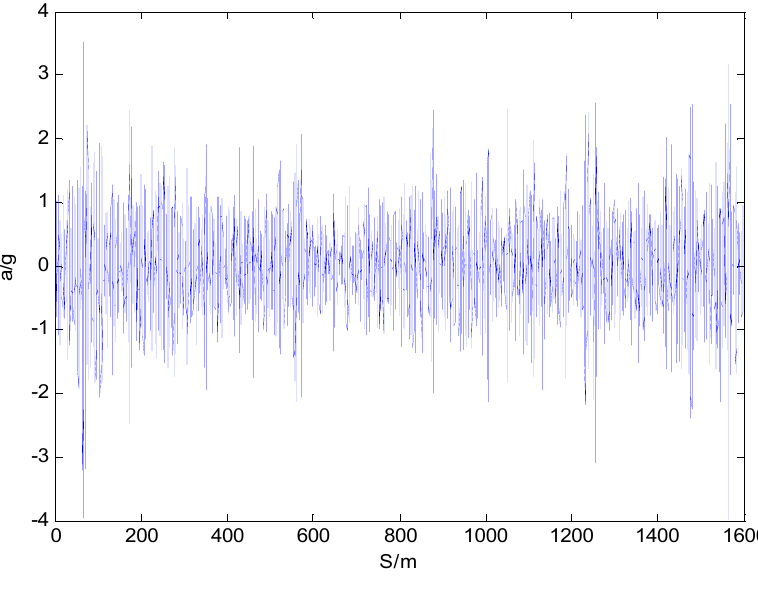
Figure 12. Space PSD of acceleration G